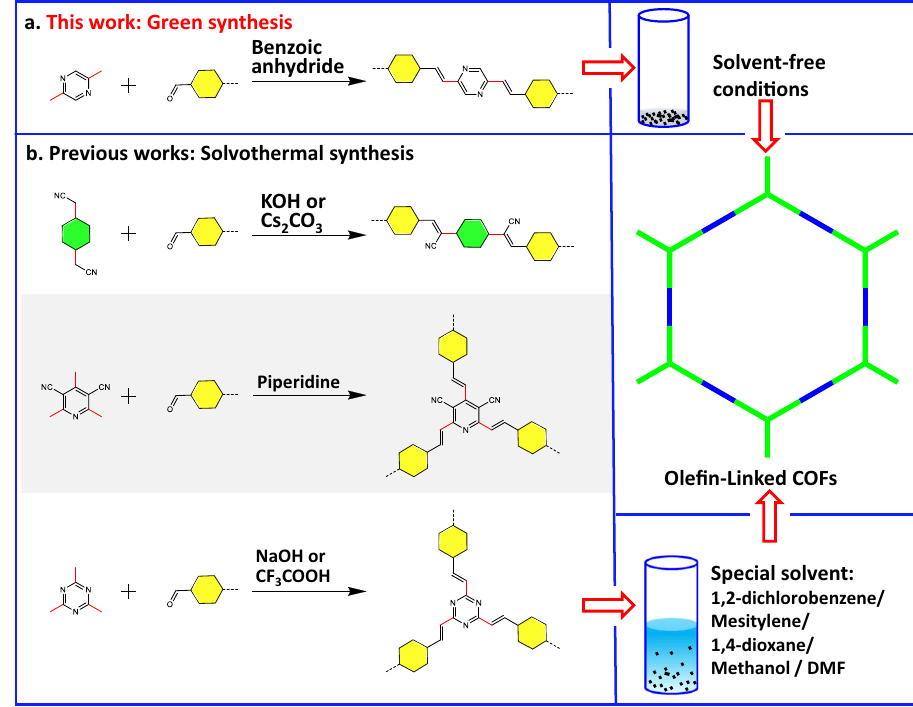
Fig. 1 Design and reactions. a Schematic representation of ole fi n-linked COFs through green synthesis. b Previous works of 2D ole fi n-linked COFs through the solvothermal synthesis.